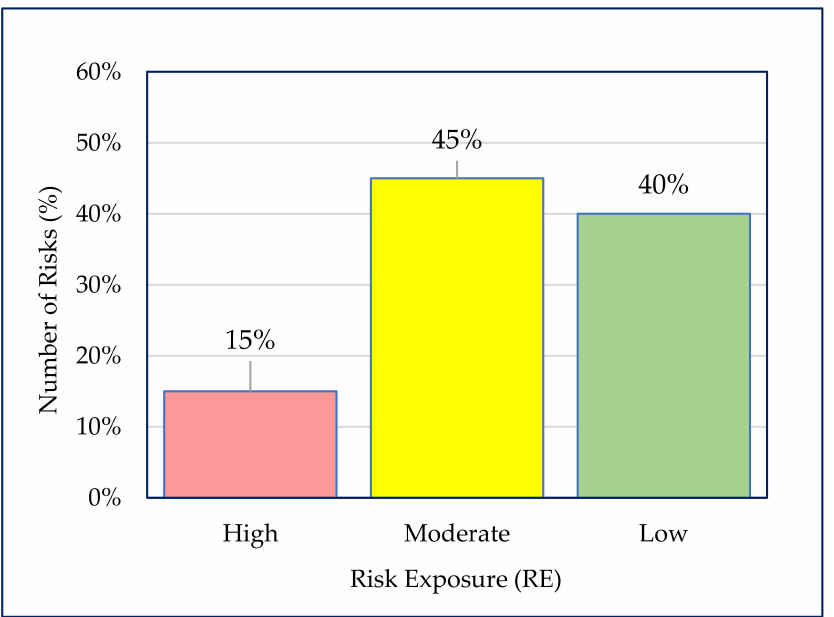
Figure 6. Risk exposure